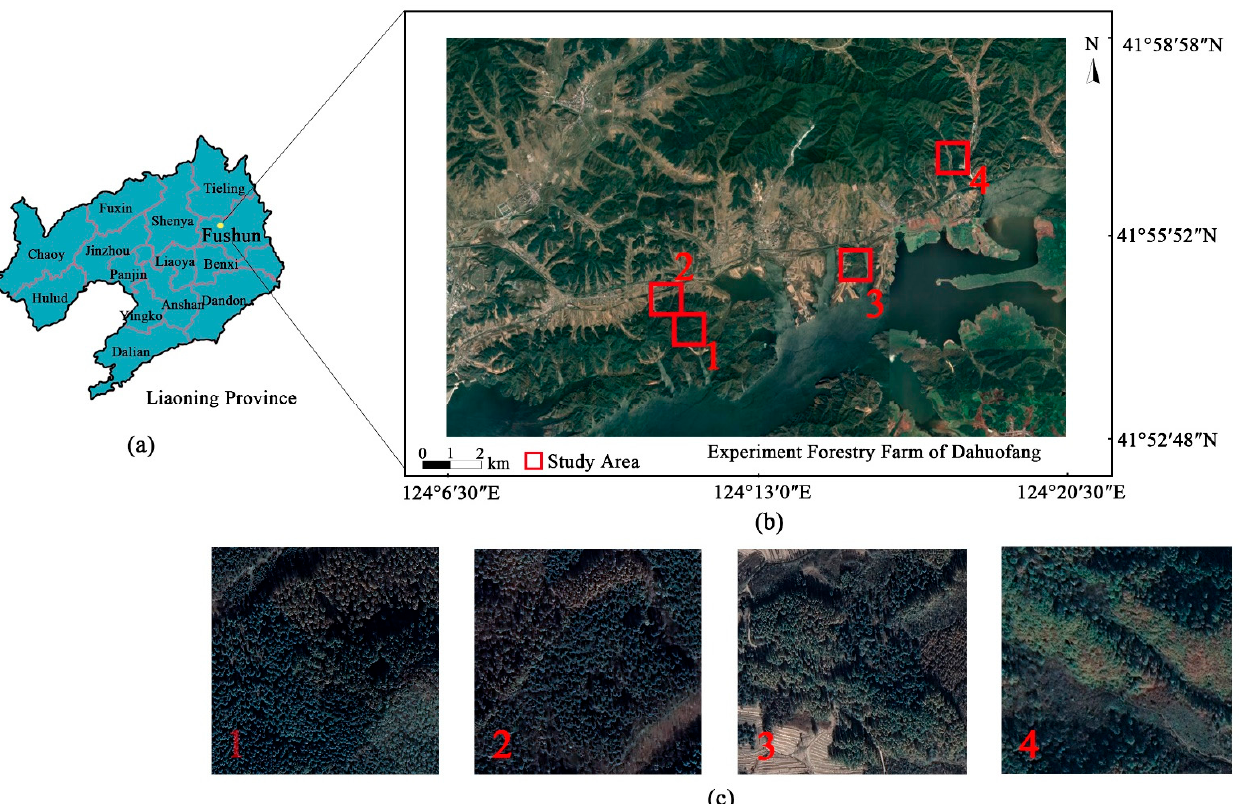
Figure 1. Location of the study areas: ( a ) The map of Liaoning Province; ( b ) the location of the study areas, where the red squares represent four study areas and the 1–4 is the numbers of the study areas; ( c ) the study areas as seen in Google Earth high-resolution images acquired on 16 October 2020.